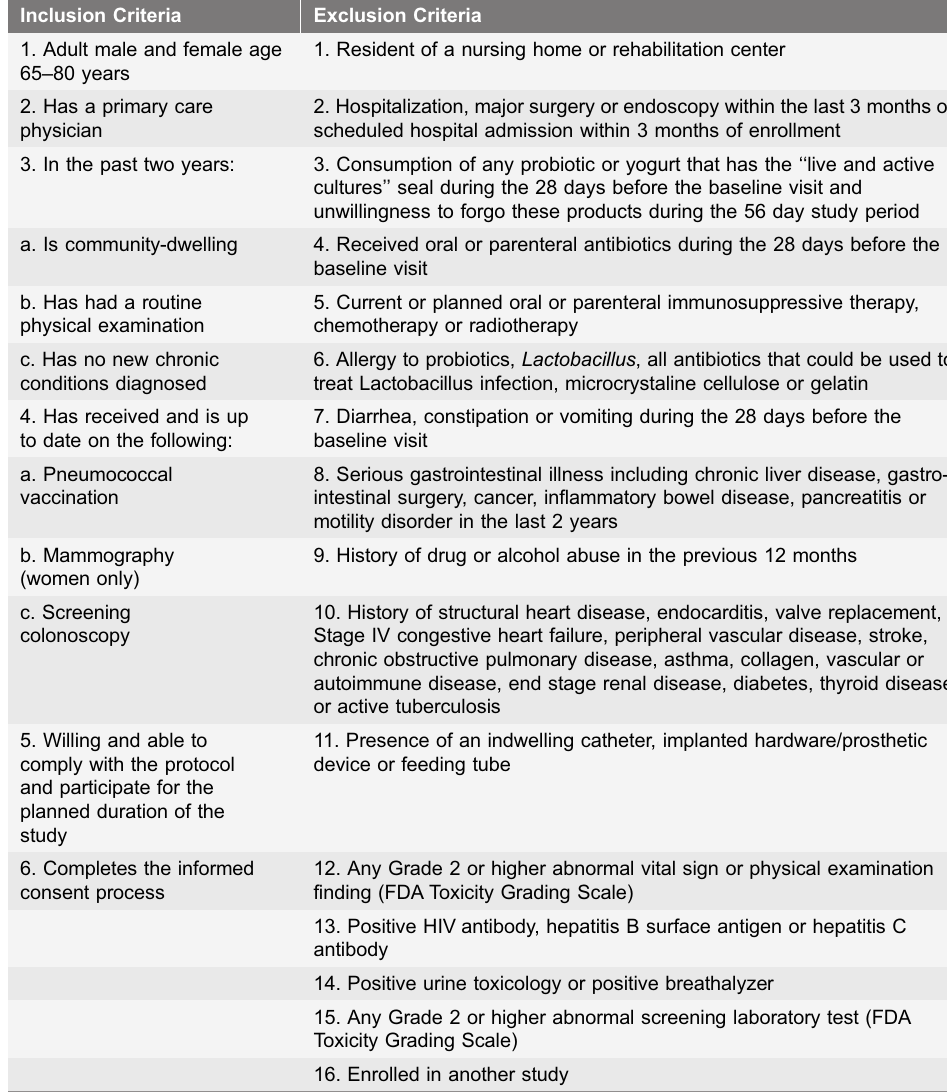
Table 1. Inclusion and exclusion